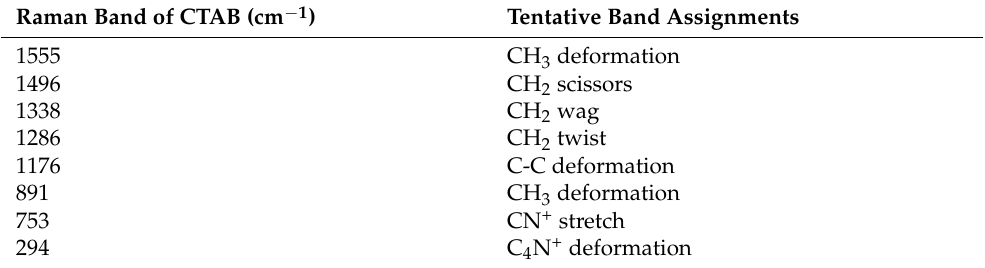
Table 1. Raman bands of CTAB observed under this investigation and corresponding band